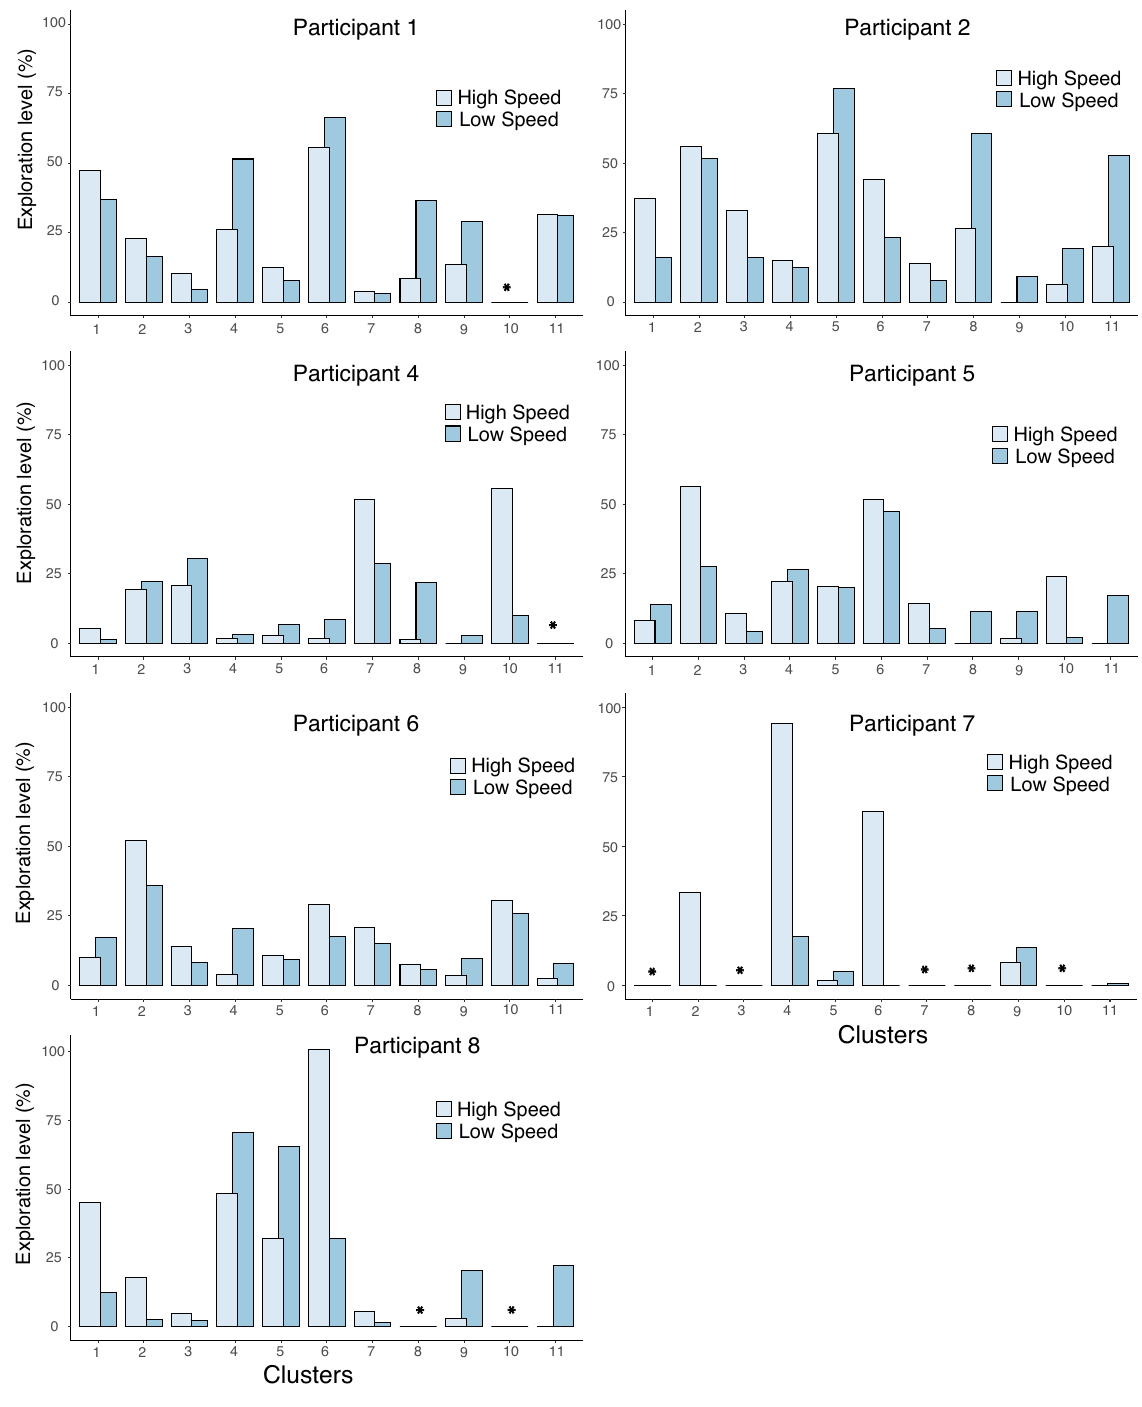
Figure 5. Exploration quantity. Individual quantities of exploration for each participant and each pattern in both low and high-speed conditions (*indicates a pattern that was never visited by this